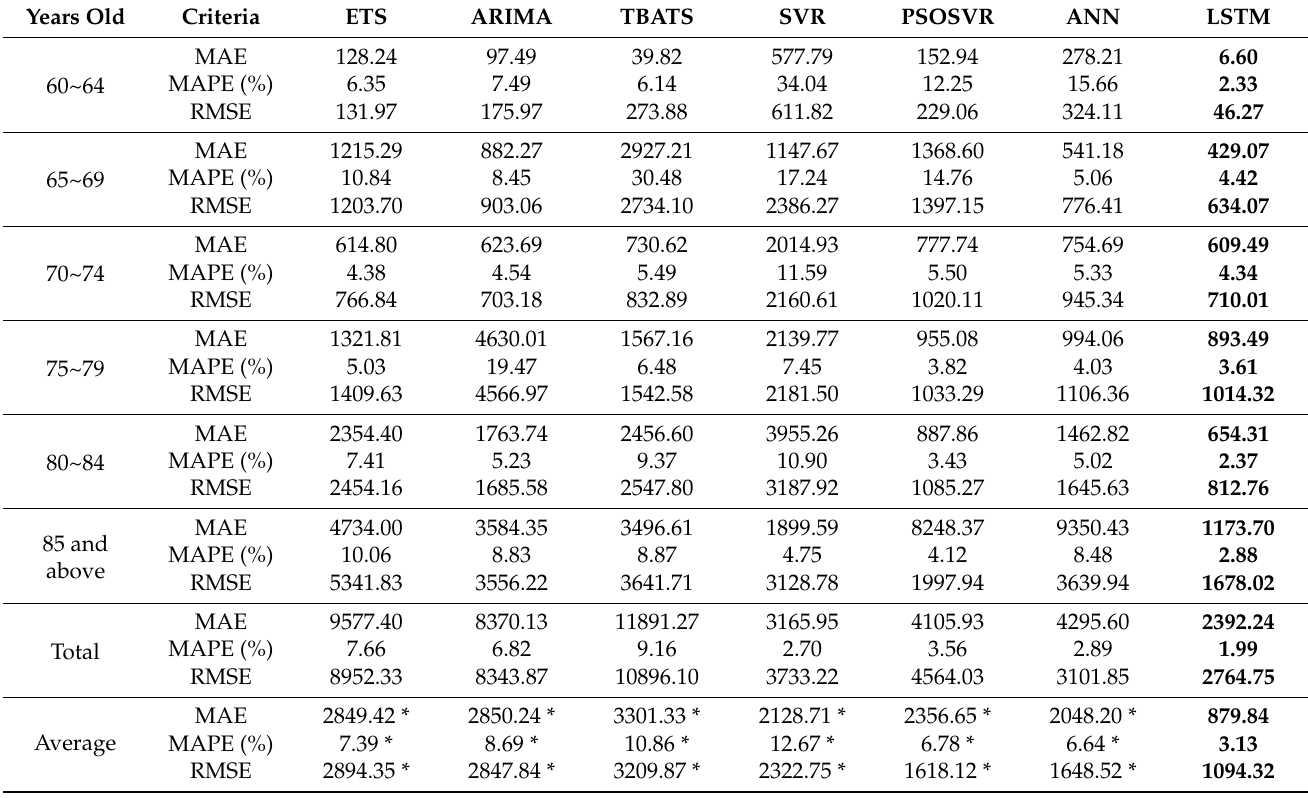
Table 5. Predicted results for female dementia patients using different